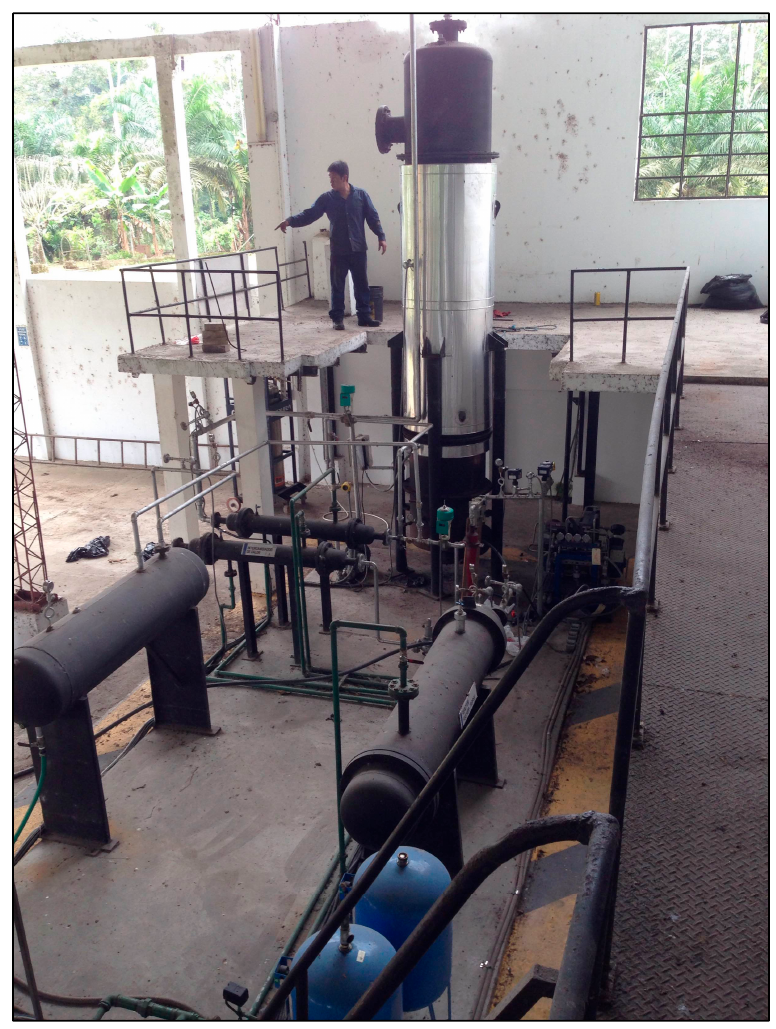
Figure 2. Gasification facility image.